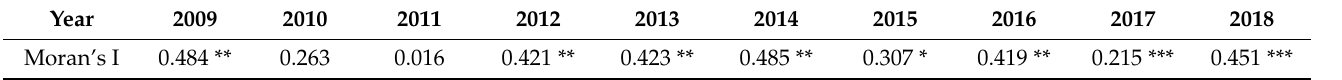
Table 3. Marine fisheries vulnerability global Moran’s I.